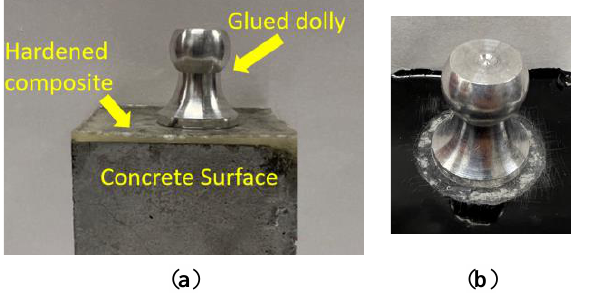
Figure 3. ( a ) Setup of adhesion test between nanocomposite and concrete surface, ( b ) the glued the dolly before testing.